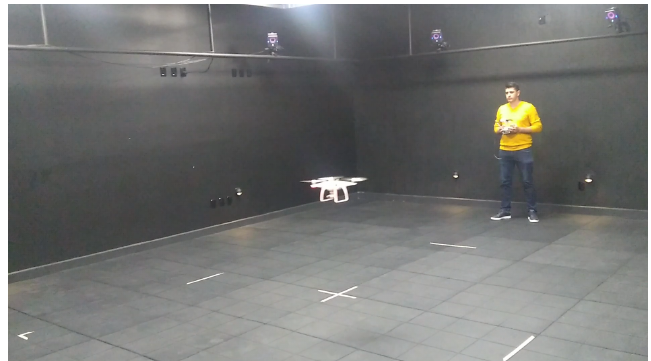
Figure 11. Drone flight in the concrete